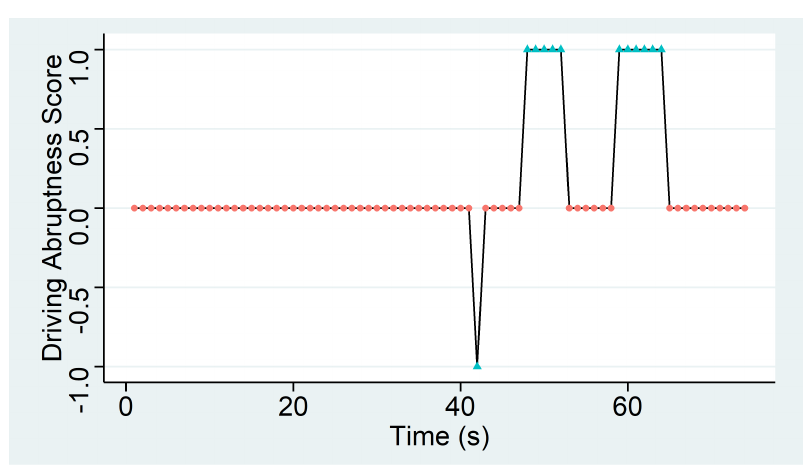
Figure 5. Results of simulation of the Z-Peak Algorithm.